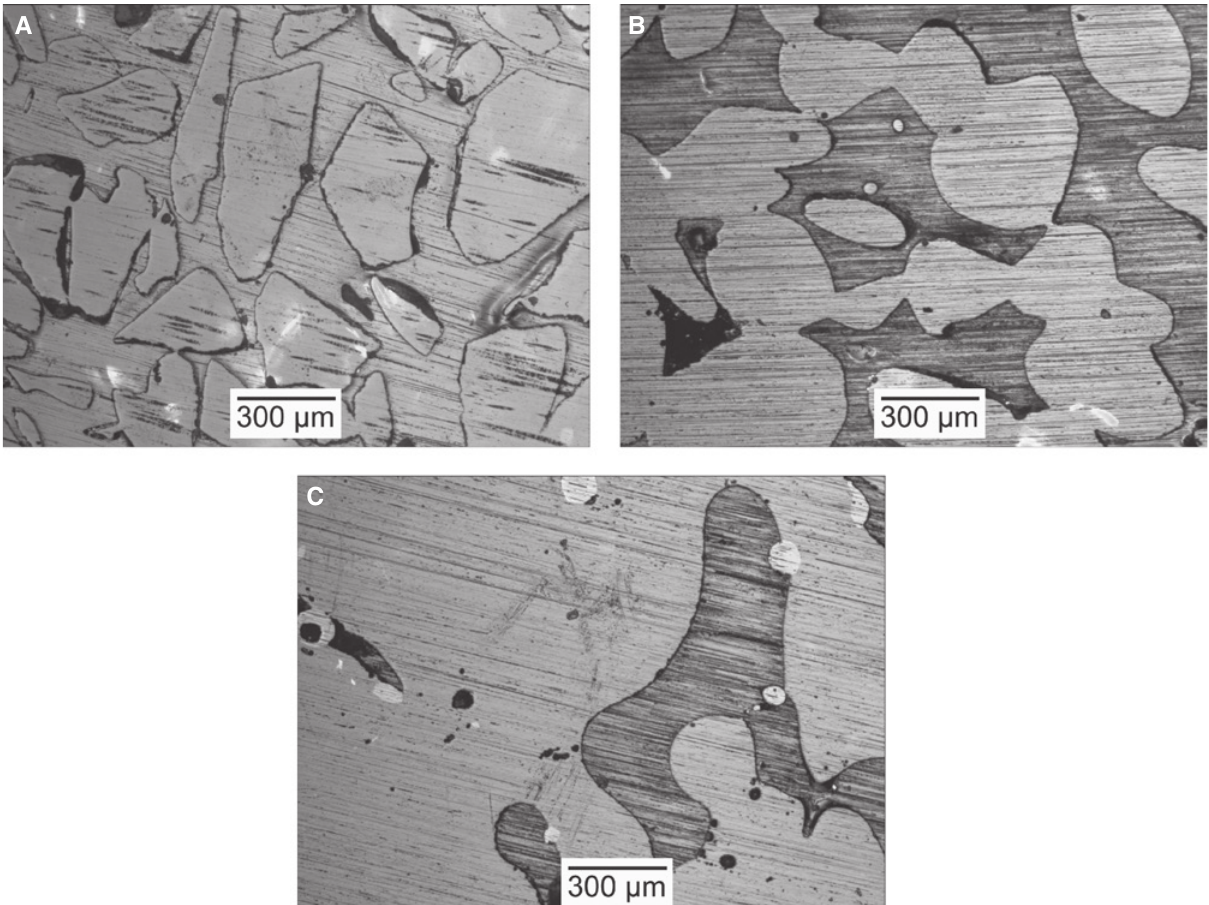
Figure 3: Sintered glass micrographs of MG30 recycled glass sintered for 15 min at (A) 725 ° C, (B) 775 ° C, and (C) 800 °